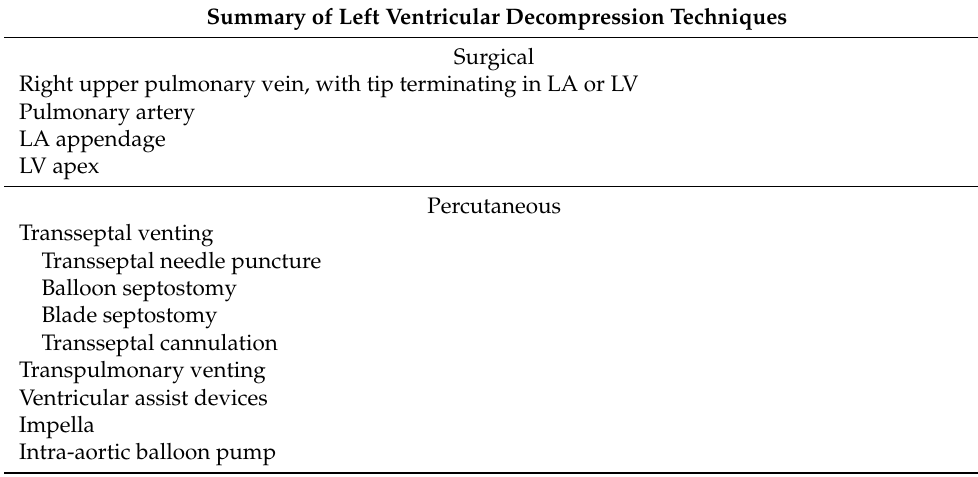
Table 4. Summary of left ventricular decompression techniques. Adapted from Xie et al. [62]. Summary of Left Ventricular Decompression